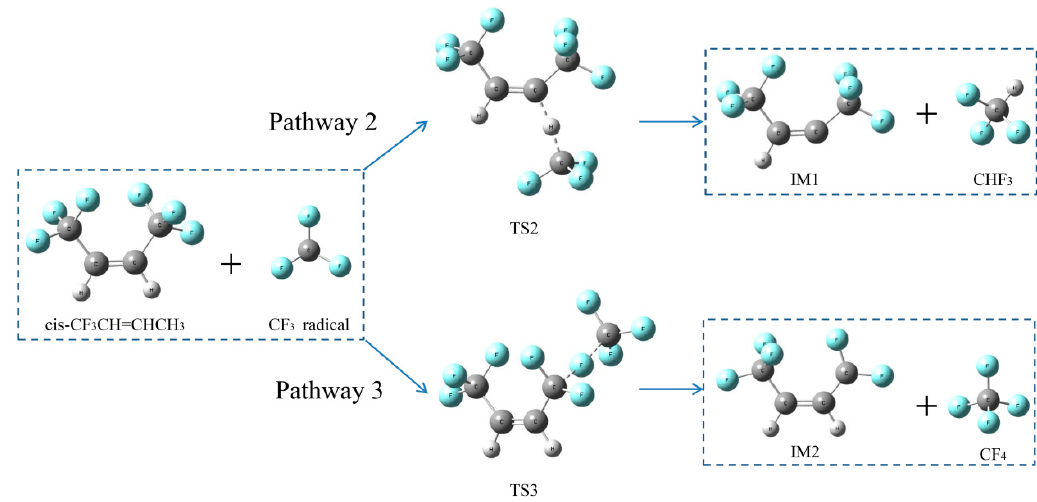
Figure 13. Two proposed pathways for cis ‐ CF 3 CH=CHCF 3 +CF 3 • reactions. C, H and F atoms are represented with black, gray and blue balls, respectively.